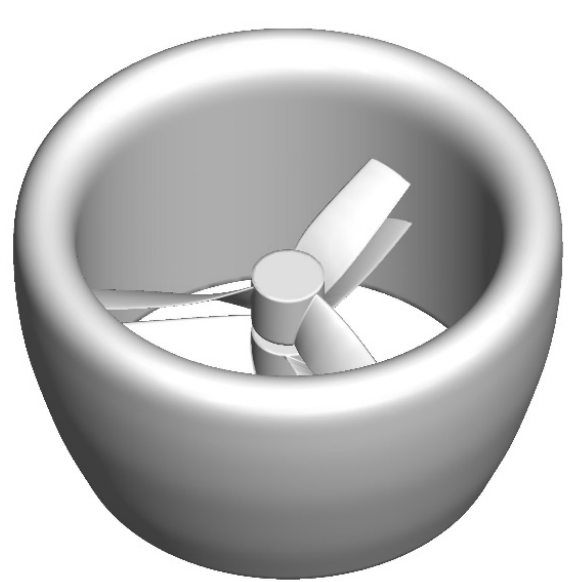
Table 1. Parameters of ducted fan UAV. Figure 11. Ducted fan